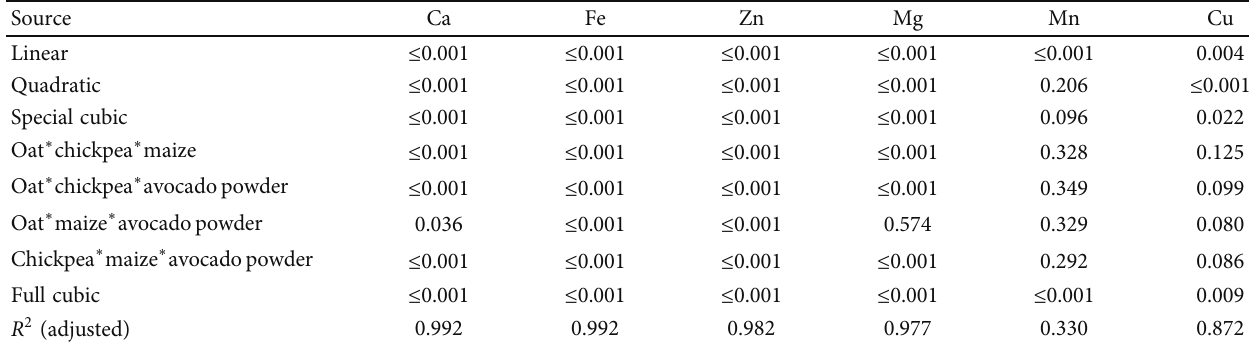
Table 3: ANOVA p values for full cubic regression model for Ca, Fe, Zn, Mg, Mn, and